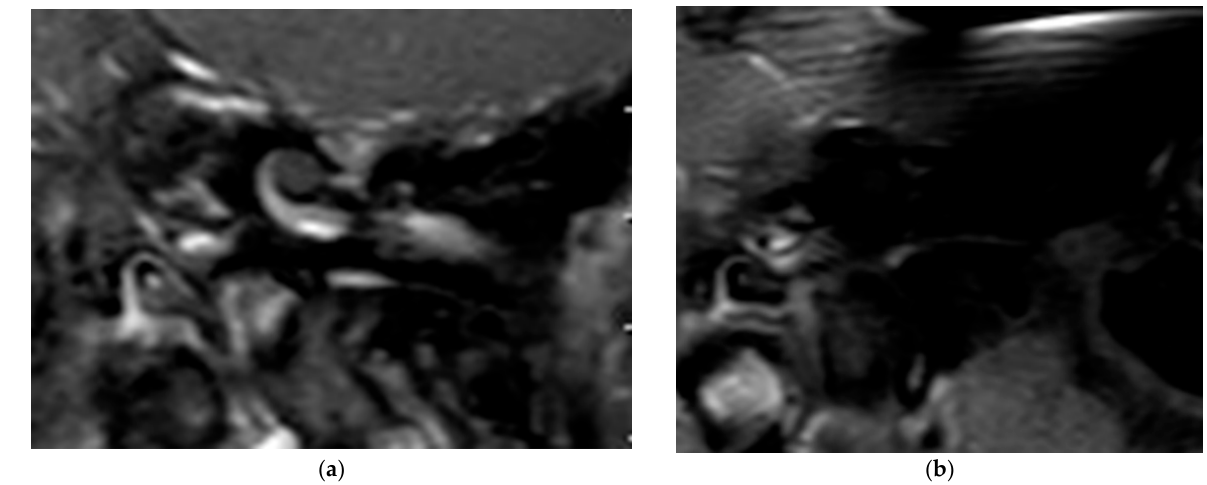
Figure 2. ( a ) . An exemplary ILS tumor pre-op (T1, Gad). ( b ) . The ILS region with a T1 Gad sequence after removal and CI.